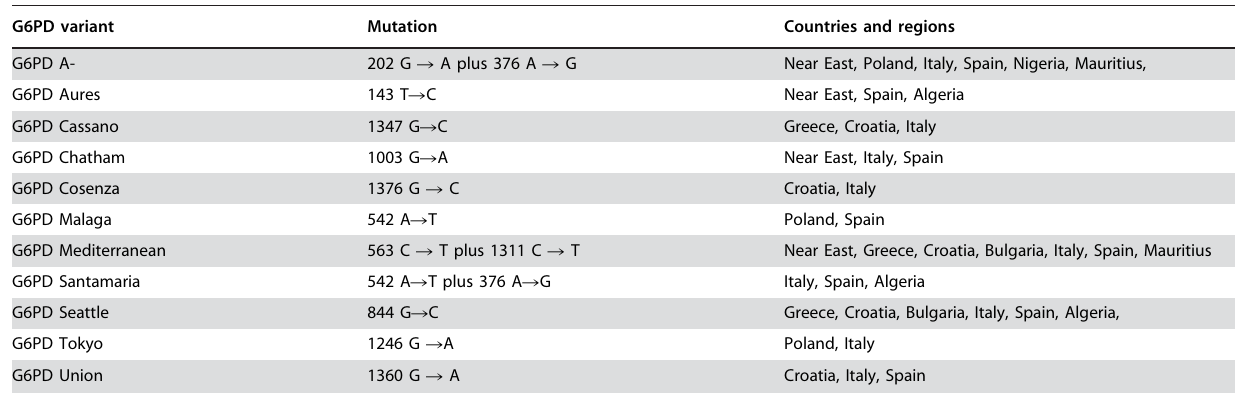
Table 2. Ubiquitous G6PD variants in Europe, Near East, and Africa .. ... .... ... ... .... ... ... .... ... ... .... ... ... .... ... ... .... ... ... .... ... ... .... ... ... .... ... ... .... ... ... .... ... ... .... ... ... .... ... ... .... ... ... .